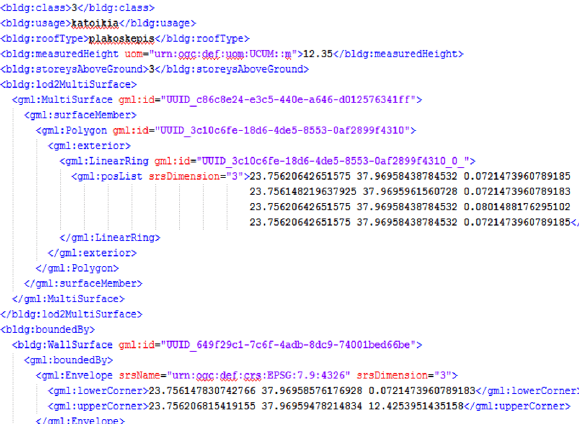
Figure 14. Part of the Exported CityGML File by 3DCityDB